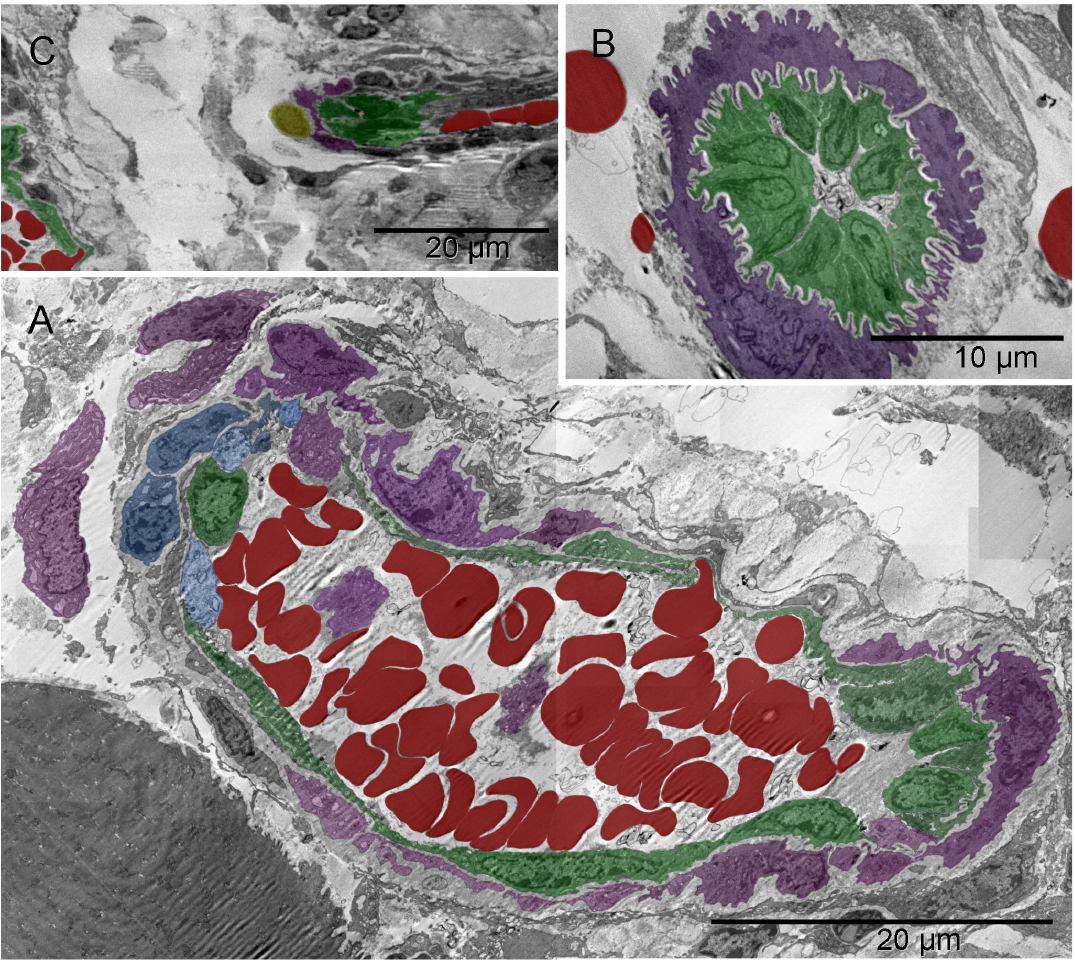
Figure S11. Morphogenesis of an artery (I). Forming lumen of the emerging vasculature fragment shown in [ A ] was occupied by free erythrosomes (red) and platelets (purple). That “vasculature piece” was not a vessel yet because it included blood elements that were being generated simultaneously with the vessel wall. The wall was incomplete at the time of image capturing. Structural differences along the circumference of the future lumen included a gap on the left side. Such lack of continuity and the irregular forms of erythrosomes also indicated that the forming vessel was not yet a part of the circulation. In that region, cells other than endothelial cells were recognizable, namely nerve and chromaffin cells (dark and light blue, respectively) and megakaryocytes (purple) at the outer side; although their products, platelets (purple), accompanied the erythrosomes in the lumen. The right side of the vessel wall was structurally the most advanced; it consisted of ECs (green) uncharacteristically non-flattened. The shape of their nuclei and corrugation of the basement membrane between those cells and supporting pericyte suggested a potential for physical expansion. Such wavy basement membrane likely contained elastic fibers. The image in [ B ] could have been from a similar region cut in a perpendicular plane with regard to that in [ A ]; nuclei of the centrally located ECs had their radial sinuses oriented towards the basement membrane. That too could facilitate the expansion of the vessel. ECs in the middle part of the main image [ A ] were flattened; in the upper side one could see an erythrosome passing through. The spatial relationship between the structures shown in [ A ] and in Figure S10 is demonstrated in [ C